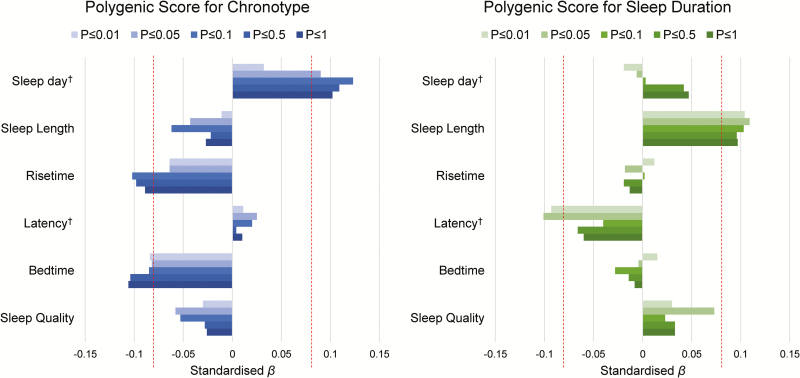
Associations between self-reported sleep characteristics and polygenic scores for chronotype (left) and sleep duration (right) at all thresholds. Red vertical dashed lines are indicative of nominal significance (p < 0.05). None survived FDR correction. Magnitude of associations (x-axis) are standardized regression coefficients, controlling for the four MDS components.